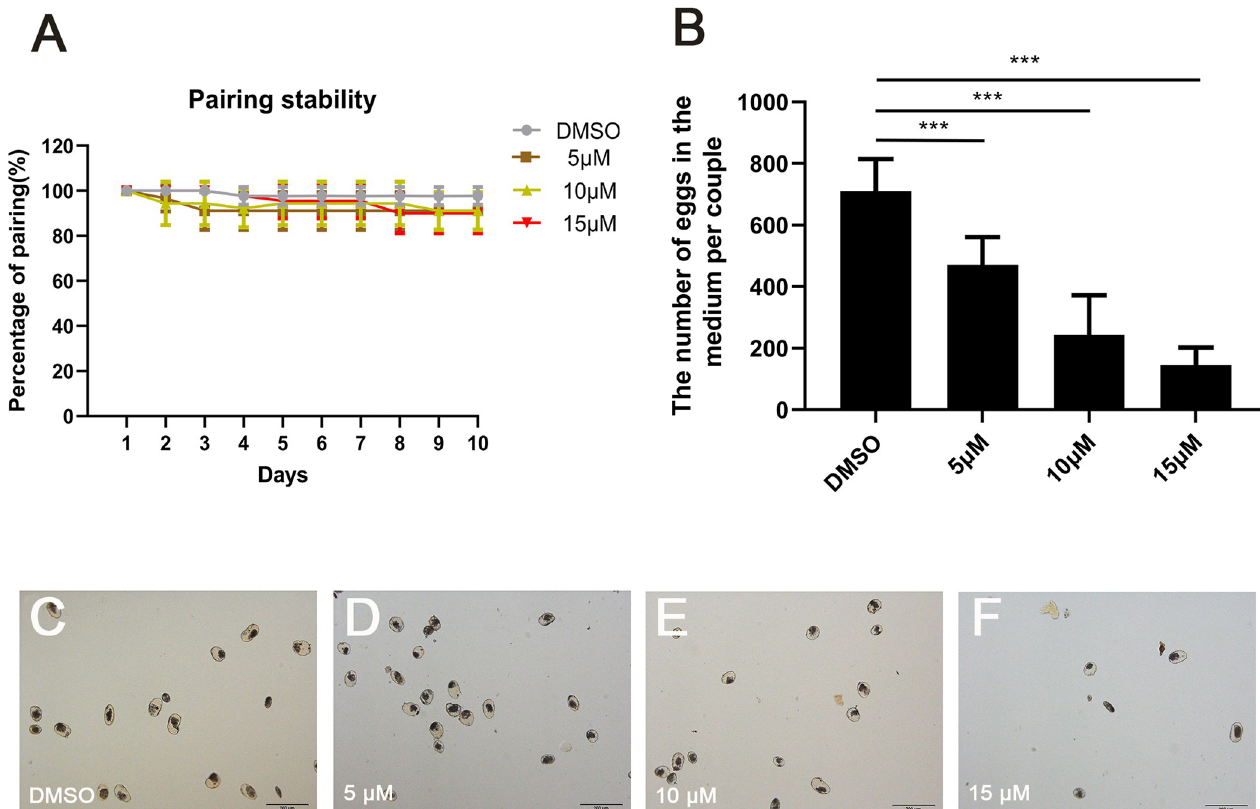
Fig 1. Effect of JQ-1 on male-female pairing rate, egg production, and egg morphology in S . japonicum . Effects of different concentrations (5 μ M, 10 μ M, and 15 μ M) of JQ-1 application on male-female pairing stability (A), egg production (B), and egg morphology (C-F) in S . japonicum pairs cultured in vitro for 10 d. Data represent the mean ± SEM of three independent experiments. Scale bars: 200 μ m. Asterisks show statistical differences ( ��� P < 0.001) tested by one- way ANOVA with multiple comparisons (Tukey’s post-hoc test).